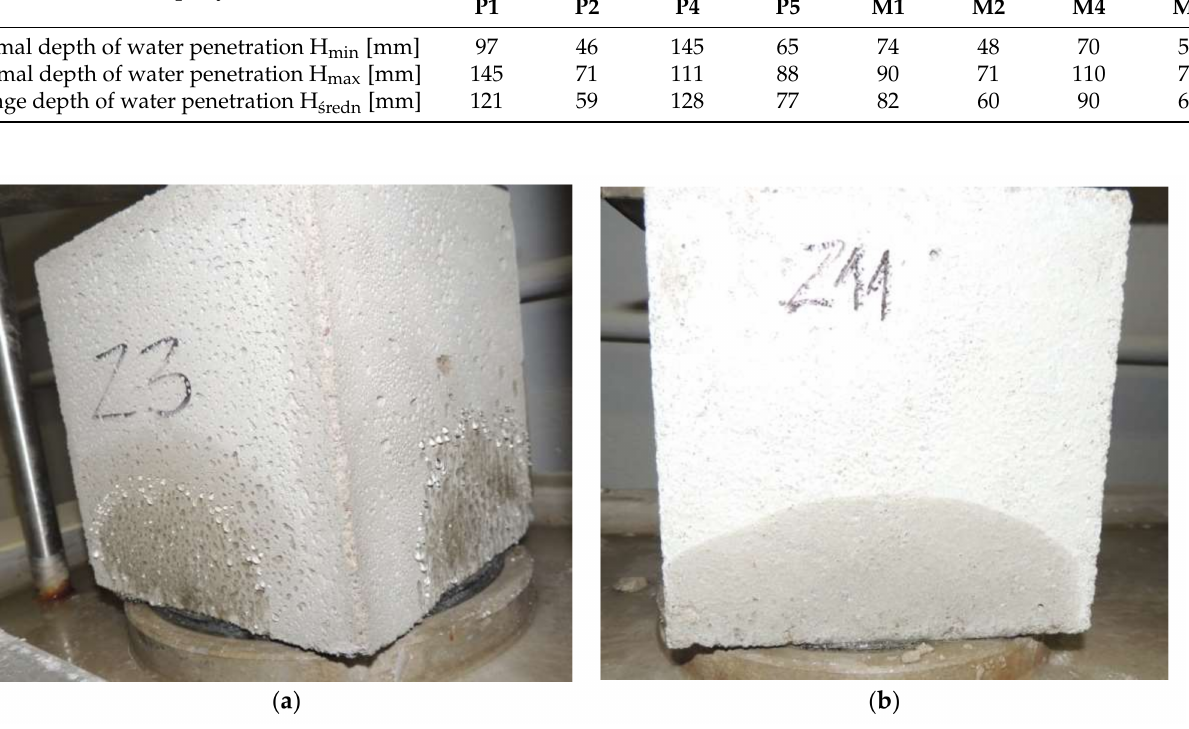
Figure 7. Example of tests of impermeability: ( a ) plaster M4; ( b ) masonry mortar M2.